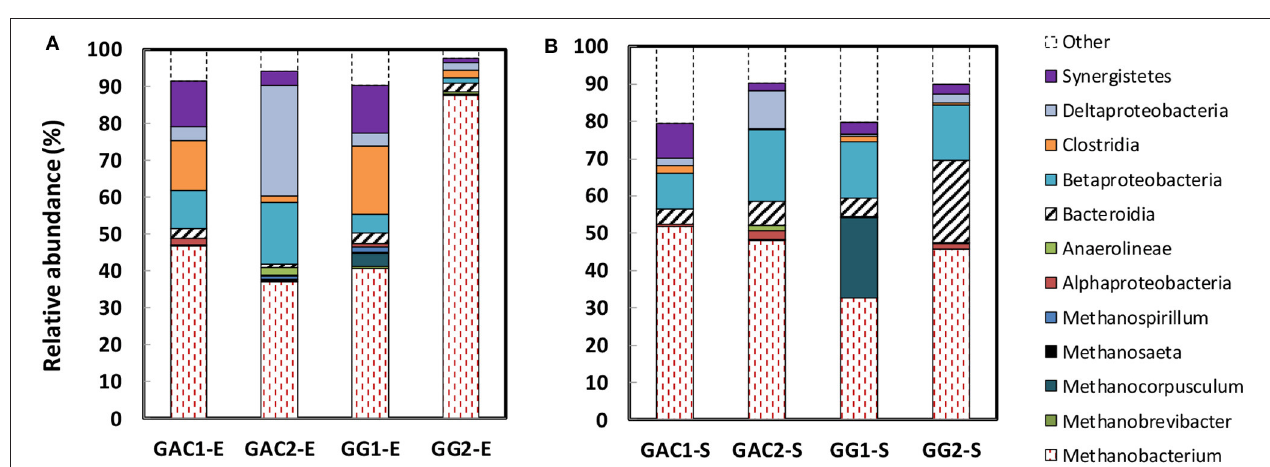
Frontiers in Bioengineering and Biotechnology |